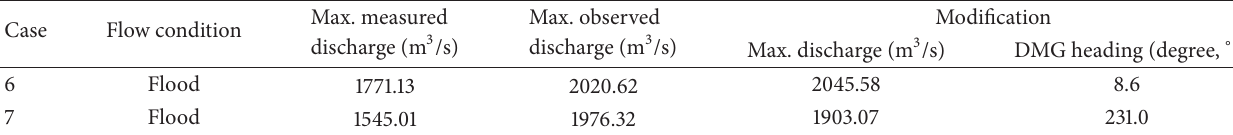
Table 6: Discharge estimation results according to DMG heading modification.